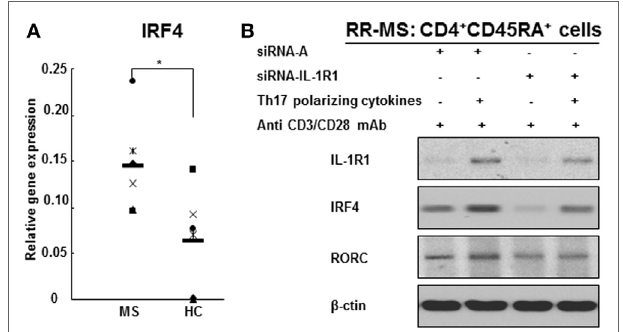
FigUre 5 | il-1r1 and irF4 are required for human Th17 cell differentiation . (a) IRF4 gene expression in the CD4 + T cell from RR MS patients is significantly increased in comparison to HCs. CD4 + T cells derived from six RR MS patients and six HCs were separated using magnetic beads, and the total RNA was extracted. The gene expression of IRF4 and 18S was measured by RT-PCR. The results are expressed as relative gene expression normalized for 18S mRNA expression. Statistical analysis was performed using t -tests. * p < 0.05. (B) IL-1R1 gene silencing downregulates IRF4 and